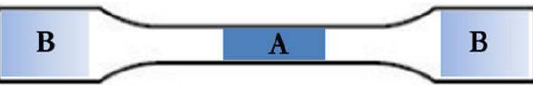
Figure 4. The measured areas of specimens for hardness tests.